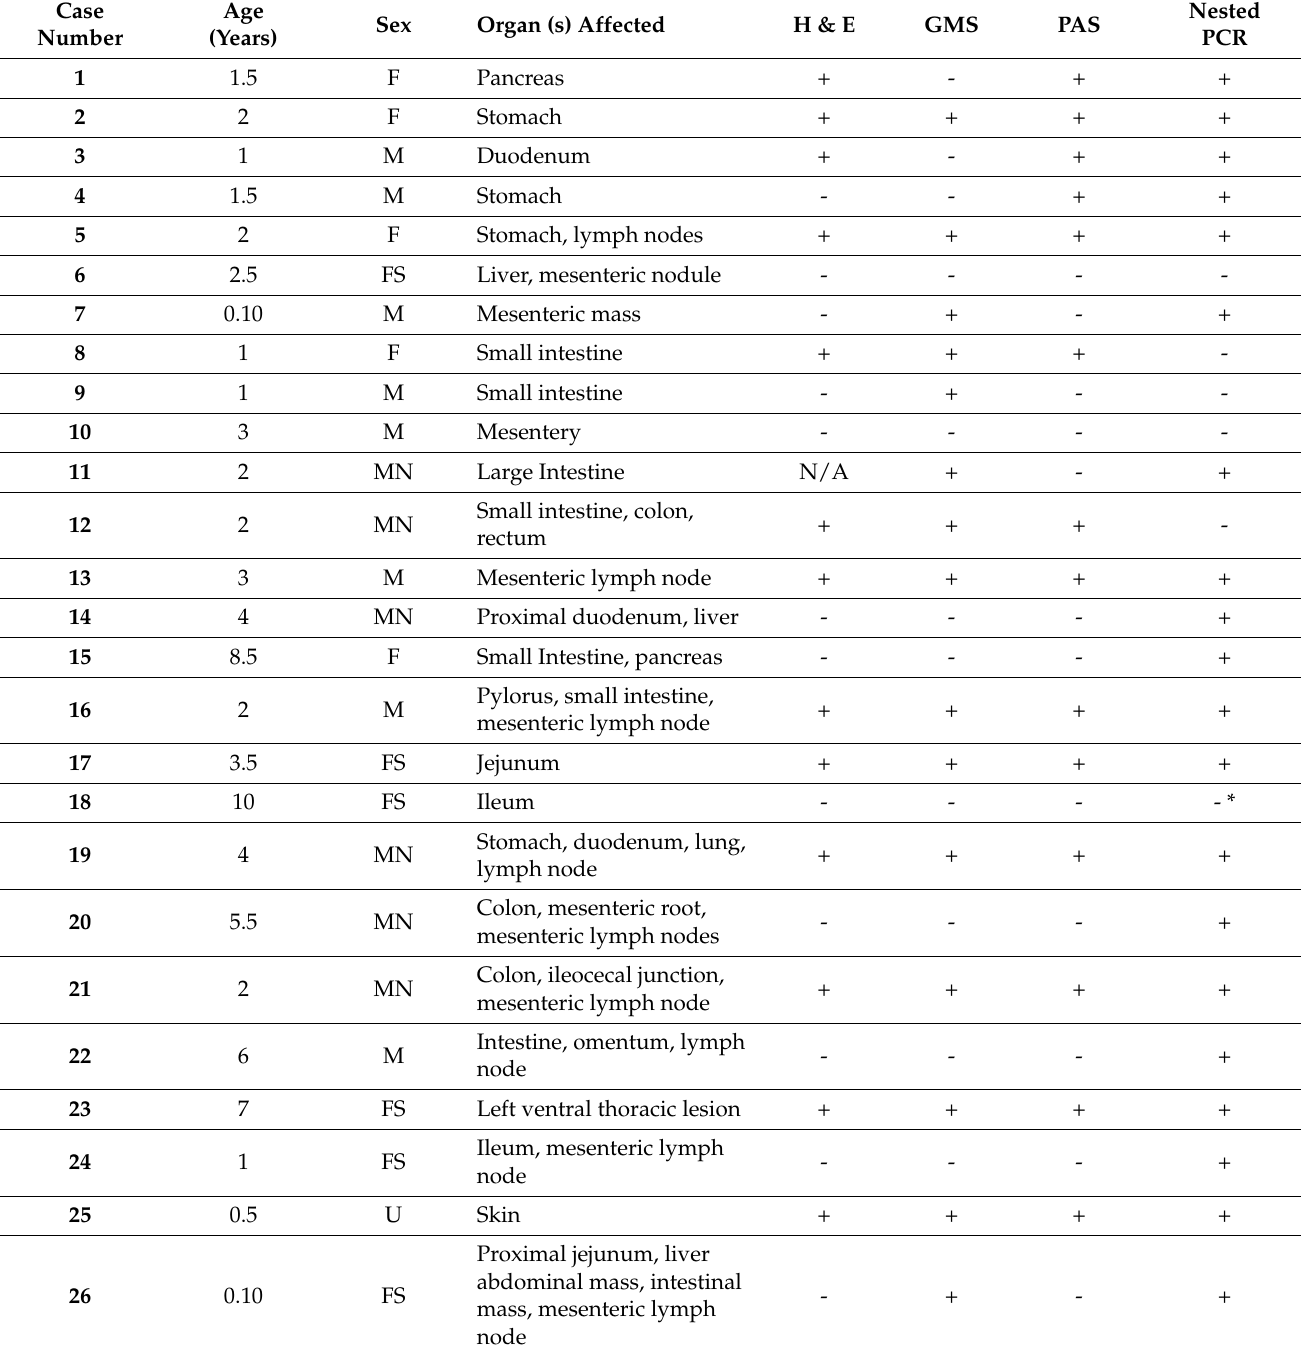
Table 1. Summary of the results of each case selected and comparisons between the microscopic observation of hyphae in the H&E, GMS, and PAS stains to the nested PCR assay developed in this